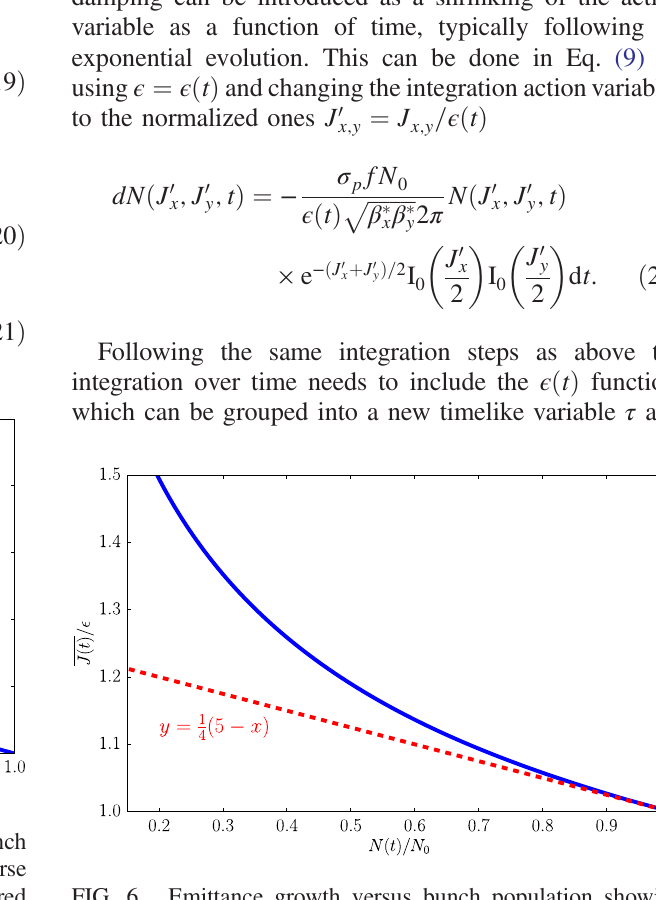
FIG. 6. Emittance growth versus bunch population showing linear approximation from Eq.